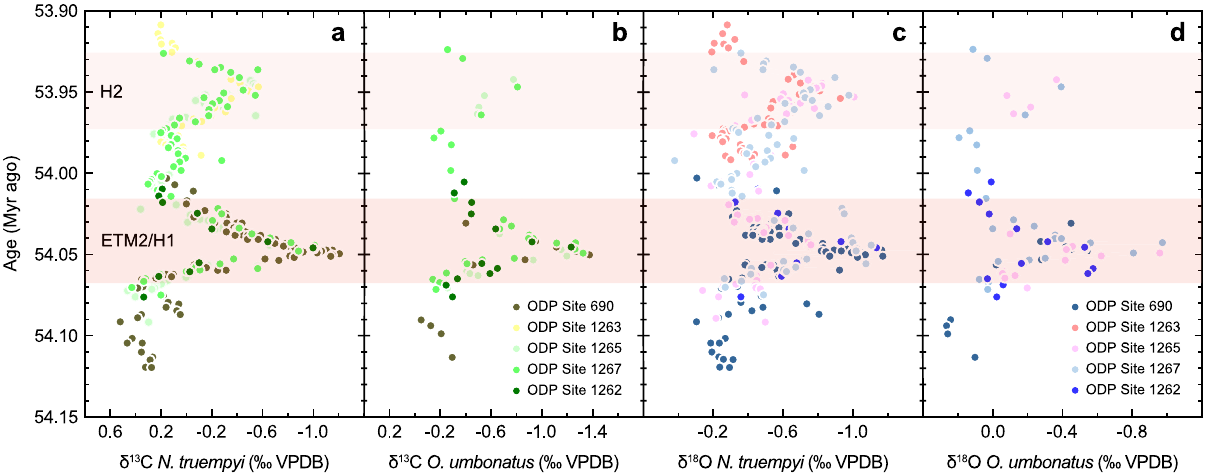
Fig. 1 South Atlantic benthic foraminiferal δ 13 C and δ 18 O records across ETM2 and H2. The fi gure shows the δ 13 C and δ 18 O measurements of benthic foraminifera N. truempyi ( a and b , respectively) and O. umbonatus ( c and d , respectively). The offsets in the stable isotopes between the two species suggest species-speci fi c vital effects 30 . The sites from the Walvis Ridge used for benthic foraminiferal stable and clumped isotope analysis include ODP Sites 1262, 1263, 1265, and 1267. Paleowater depth of these sites ranges from ~1500 to ~3600 m in the order 1263, 1265, 1267, 1262 (shallow to deep) 17,67 . Maud Rise is represented by ODP Site 690 with a ~2100 m paleowater depth 68,69 . The stable isotope data are plotted against age following the age models of Stap et al. 66 and Westerhold et al. 126